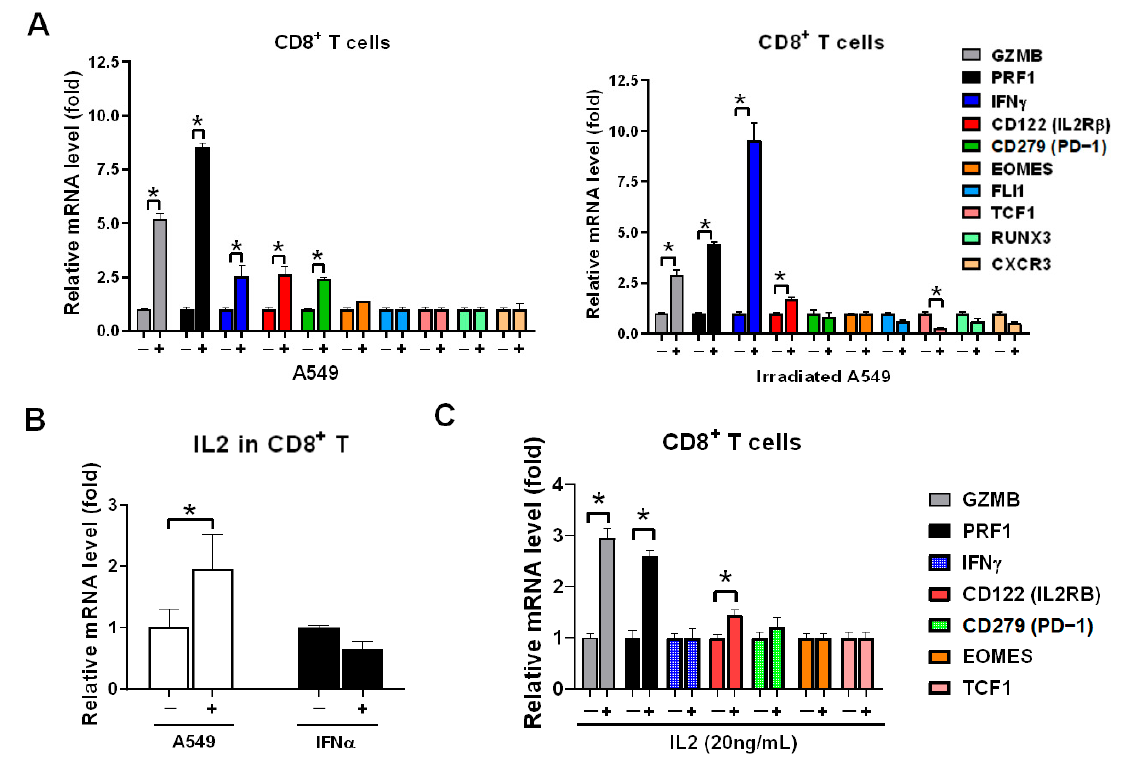
Figure 3. A549 cell lysate induced IL2 expression to stimulate GZMB and PRF1 overexpression in CD8 + T cells. ( A ) Healthy CD8 + T cells were incubated with parental and irradiated A549 cells for 24 h, and which were isolated consequently and analyzed for expression of CD8 + T cells markers using qPCR, including the genes associated with the activation: GZMB , PRF1 , IFN γ , CD122 (IL2RB), inhibition: CD279 (PD-1), transcriptional factor: EOMES , FLI1 , TCF1 , RUNX3 , and migration receptor: CXCR3 . ( B ) CD8 + T cells were individually treated with A549 cell lysate or 20ng/mL of IFN α for 2 h, and IL2 expression was detected using qPCR. ( C ) CD8 + T cells were treated with 20 ng/mL of IL2 for 2 h, and the genes of CD8 + T cell markers were detected using qPCR. The quantification was calculated based on 3-times repeat in qPCR assay. * p < 0.05.